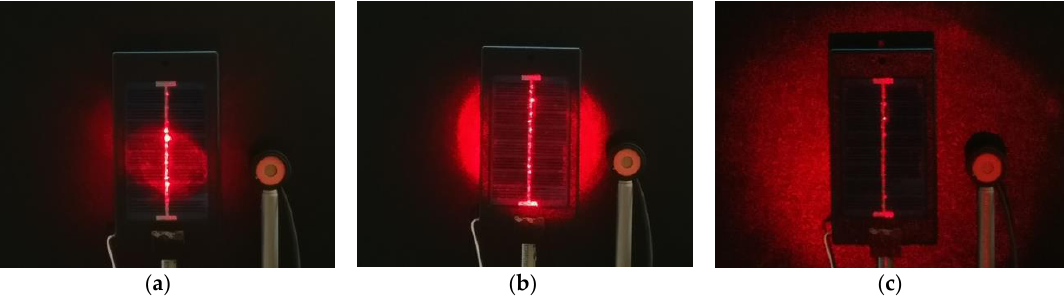
Figure 5. Illumination patterns on a solar panel ( a ) highly concentrated; ( b ) partially illuminated; ( c ) completely illuminated.